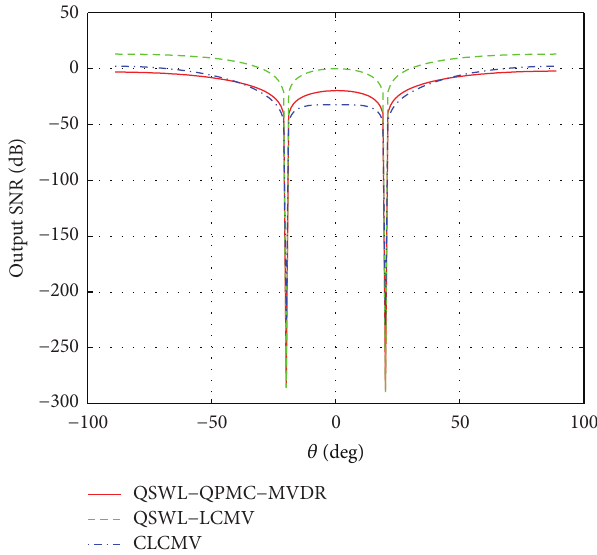
Figure 5: Effect of the angular mismatch between the distortionless constraint direction and the real arrival direction of the desired signal at 𝑀 = 3